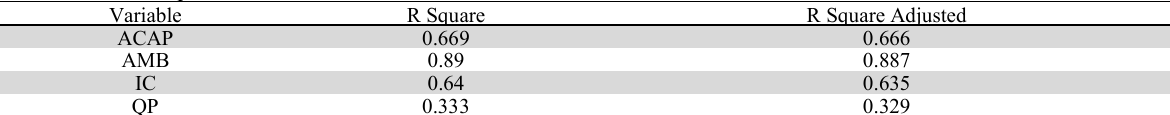
The results of R-Square